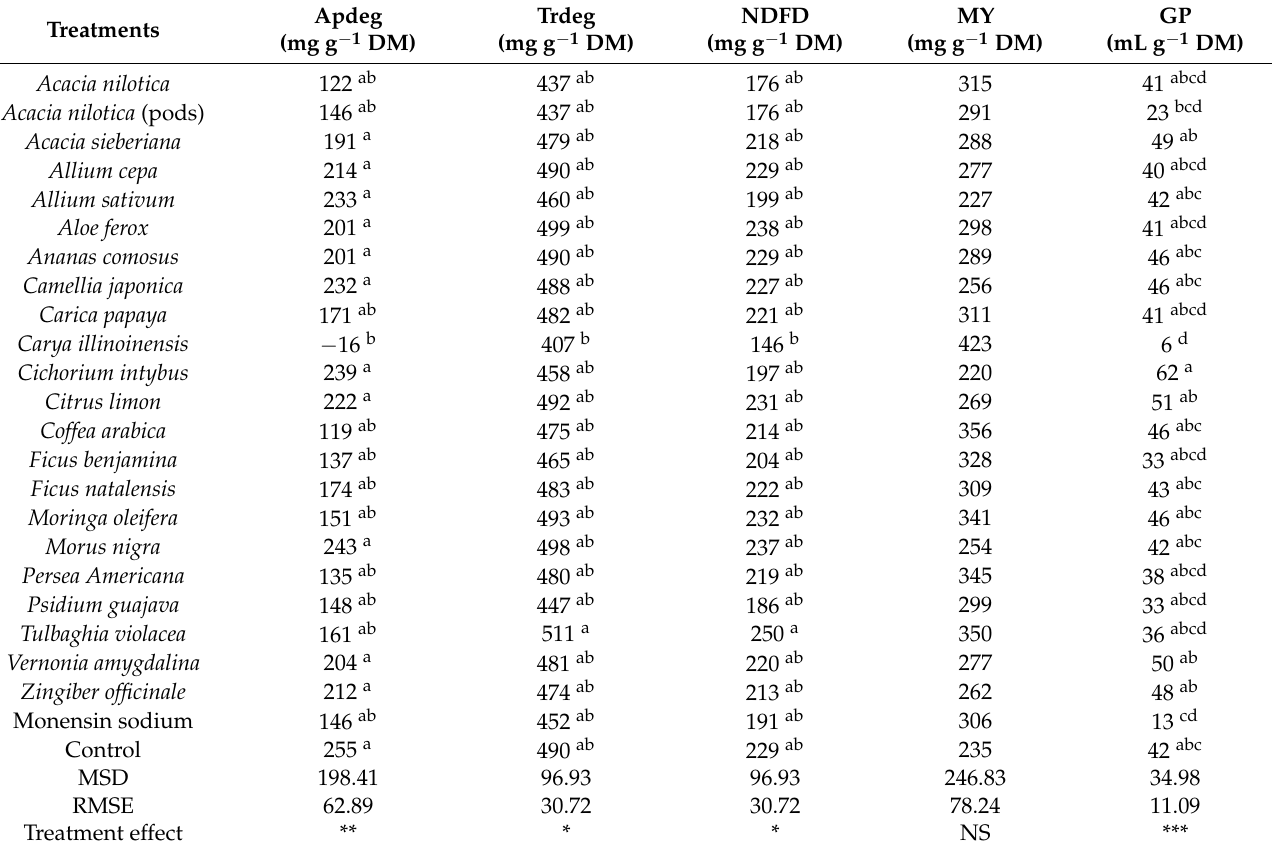
Table 2. Degradability and gas production of Themeda triandra hay as influenced by the inclusion of plant extracts rich in phytochemicals and monensin at 16 h of fermentation in